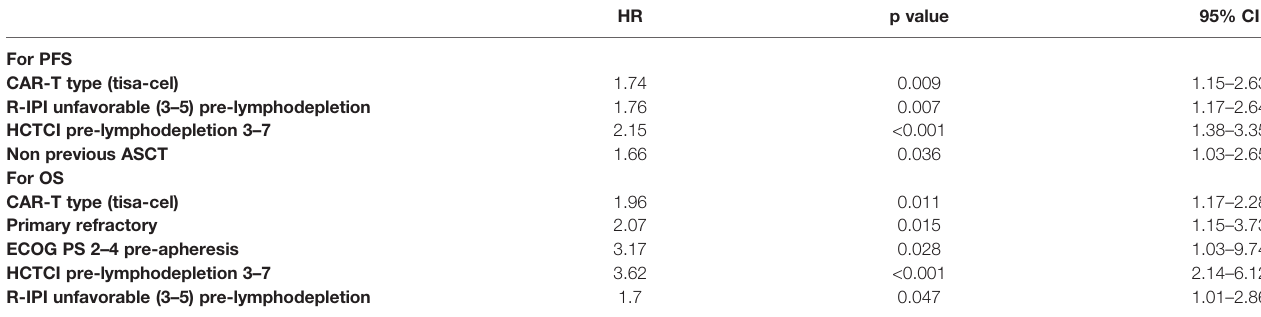
TABLE 5 | Multivariable analysis of survival in CAR-T-infused patients.